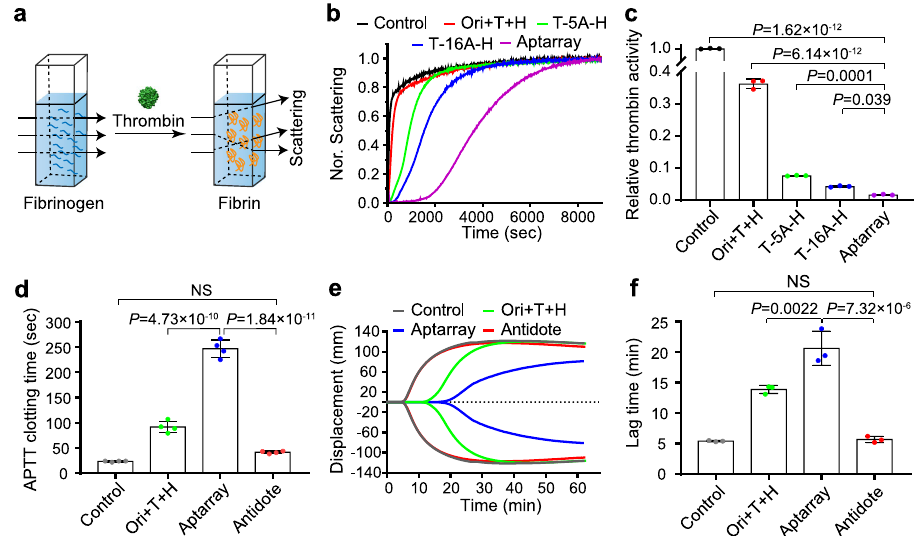
Fig. 3 Inhibitory effects of the DNA origami-based aptamer nanoarray and anticoagulant reversal. a Schematic drawing of scattering spectra detection of fi brin formation after the activation of fi brinogen by thrombin. b Light scattering spectra ( λ sc = 650 nm) of a fi brinogen solution with thrombin only (Control) or thrombin with the mixture of origami and two types of aptamers (Ori + T + H: ~0.56 nM origami, 20 nM TBA15, 20 nM HD22), aptamers tethered with 5-mer (T-5A-H, 20 nM) or 16-mer polyA linkers (T-16A-H, 20 nM), or the DNA origami-aptamer nanoarray (Aptarray: ~0.56nM origami, 20 nM TBA15, 20 nM HD22). c Relative thrombin activities of different treatments were estimated by the catalytic rate of thrombin with indicated groups. The catalytic rate of thrombin ( V cat ) after the indicated treatments was calculated as V Cat = C Fibrinogen /( t 1/2 × C Thrombin ) obtained from the panel b . The concentration of fi brinogen ( C Fibrinogen ) is 1 mg/ml, and the concentration of thrombin ( C Thrombin ) is 12 nM. d Plasma clotting time (APTT) in the absence (Control) and presence of the mixture of origami and two types of aptamers (Ori + T + H: ~56 nM origami, 2 μ M TBA15, 2 μ M HD22), the DNA origami- aptamer nanoarray (Aptarray, ~56 nM origami, 2 μ M TBA15, 2 μ M HD22), and fi vefold antidote-neutralized nanoarray (Antidote, 10 μ M cTBA15 + cHD22, mixed with Aptarray for 5 min incubation at 25 °C). e Representative TEG tracing and f the time until detectable clot formation following kaolin-initiated coagulation for each condition described. The TEG assays were performed on human whole blood from healthy donors containing no anticoagulants (Control), one of the anticoagulant strategies (Ori + T + H or Aptarray) or neutralized anticoagulant (Antidote), with the maximum time limit of a TEG assay being ~60 min. Data represent the mean ± s.d. from either three ( c , f ) or four ( d ) independent replicates. Statistical signi fi cance ( c , d , f ) was calculated by one-way ANOVA with the Tukey post hoc test. NS, P > 0.05. Source data are provided as a Source Data fi